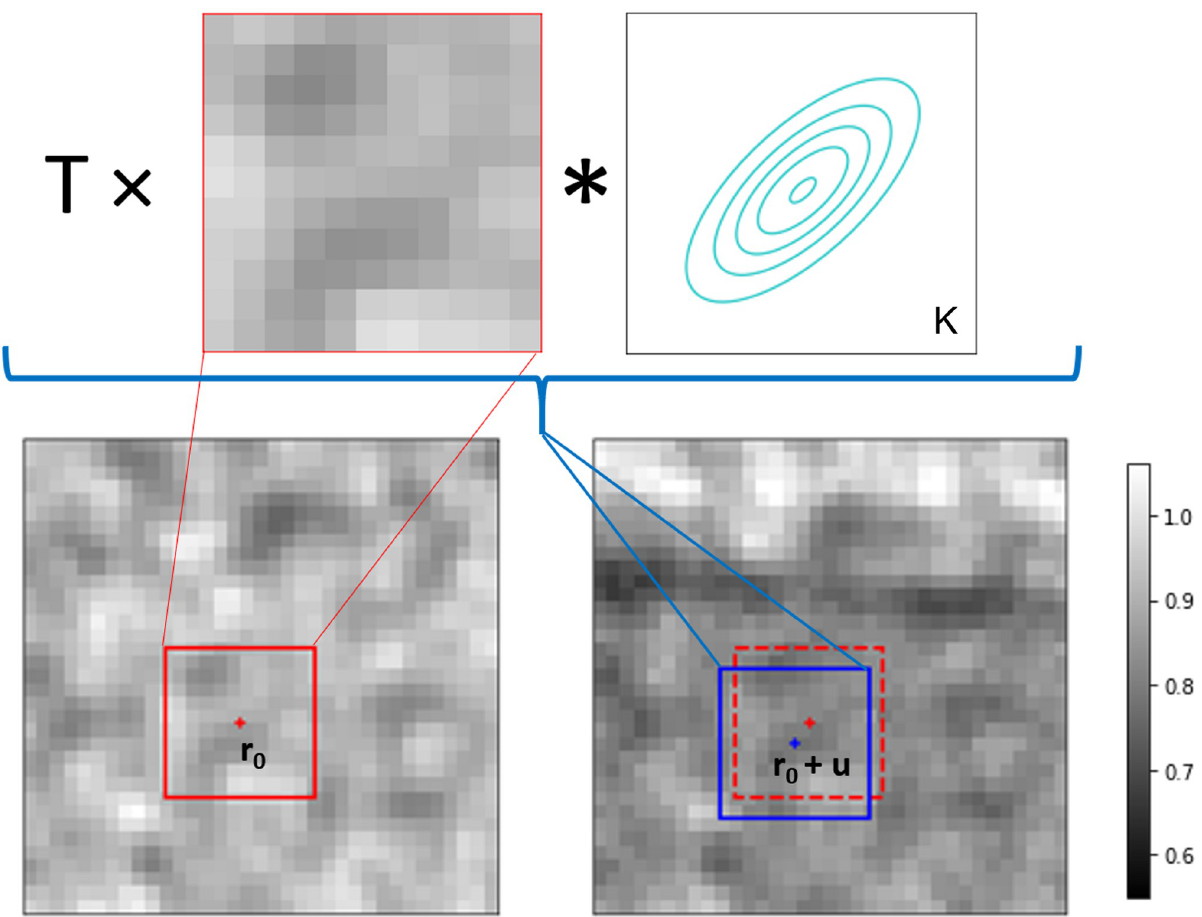
Fig 2. Graphical representation of the directional dark-field UMPA model: The speckle pattern is locally modulated by the sample transmittance ( T ), a convolution with a blurring kernel ( K α ) and a lateral shift (u). The transmittance corresponds to an image similar to the one that would have been acquired without the sandpaper in the beam. The lateral shift is used to generate differential phase-contrast images, while the parameters of K α quantify the dark-field signal. (The blurring kernel and vector shifts shown have been exaggerated).